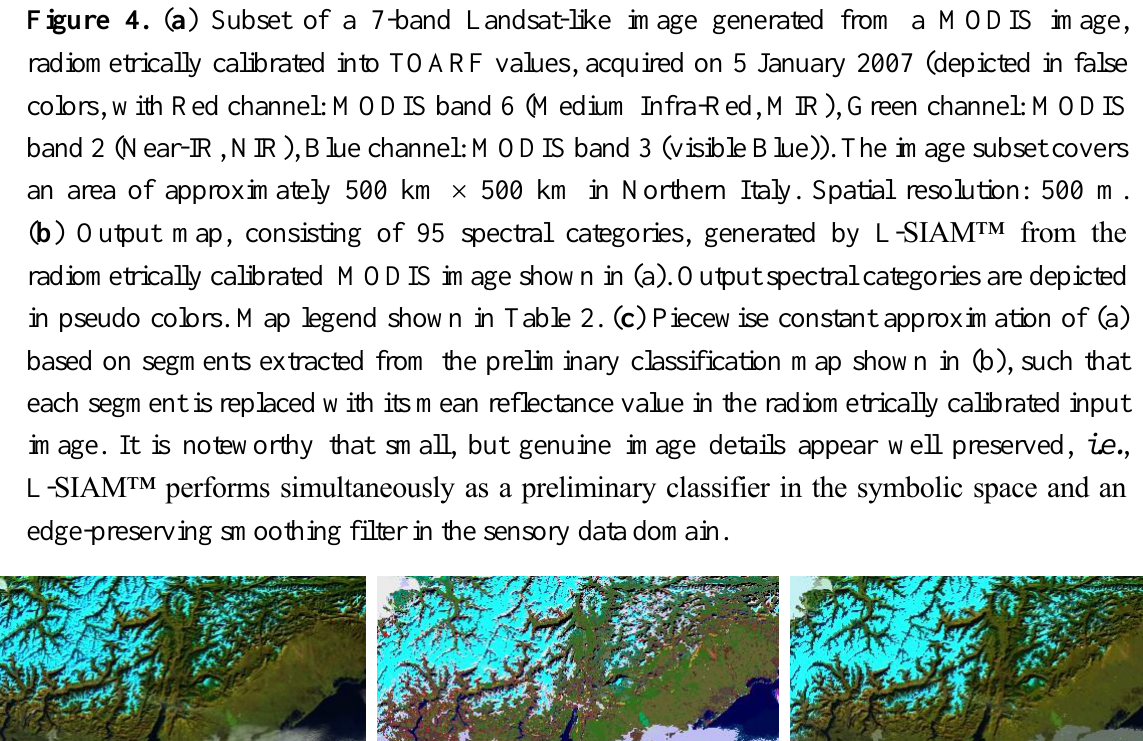
Figure 4. ( a ) Subset of a 7-band Landsat-like image generated from a MODIS image, radiometrically calibrated into TOARF values, acquired on 5 January 2007 (depicted in false colors, with Red channel: MODIS band 6 (Medium Infra-Red, MIR), Green channel: MODIS band 2 (Near-IR, NIR), Blue channel: MODIS band 3 (visible Blue)). The image subset covers an area of approximately 500 km  500 km in Northern Italy. Spatial resolution: 500 m.